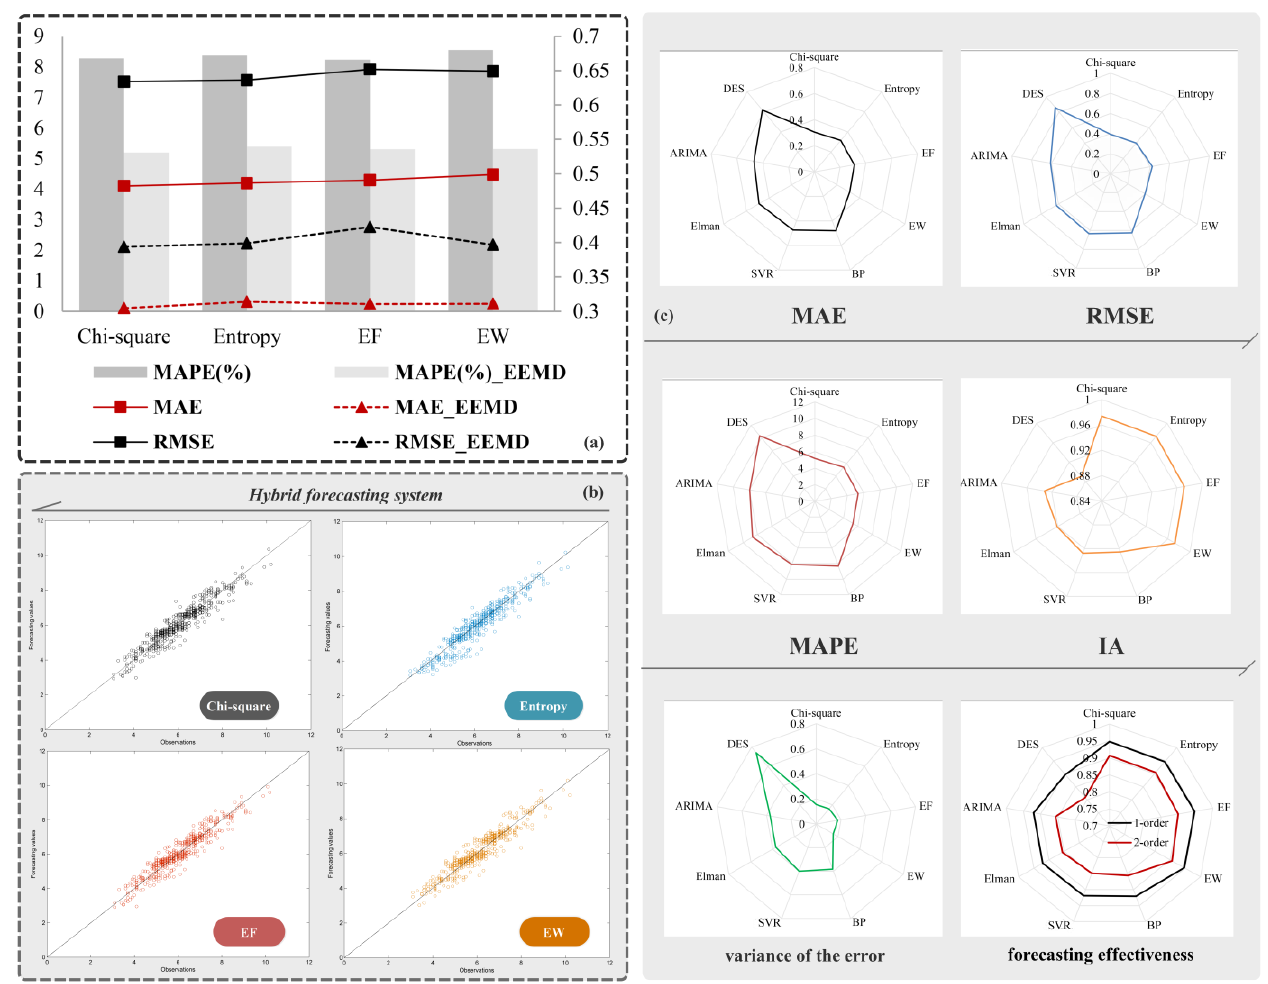
Figure 4. Comparison of forecasting results obtained using different models for Dataset I. ( a ) Comparison of the forecasting results obtained from original and pre-processing data; ( b ) Comparison of actual and forecasting values of hybrid forecasting system; ( c ) Comparison of forecasting performance for different models